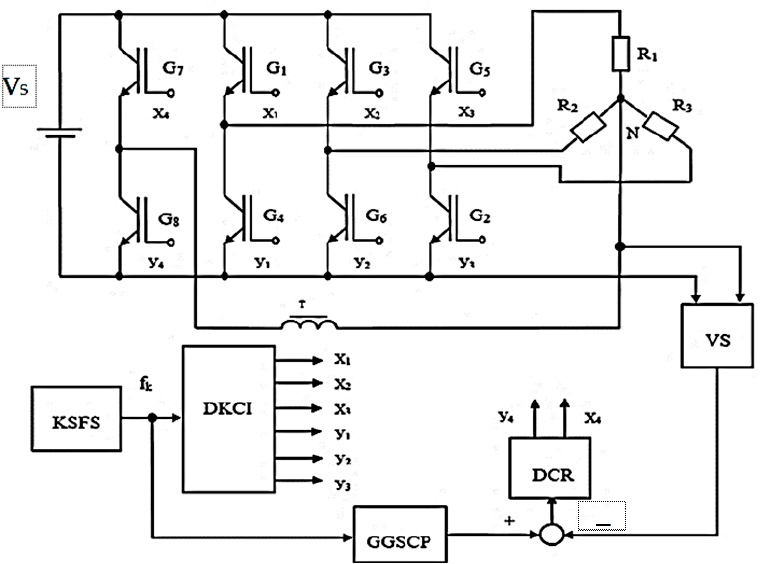
Figure 6. Diagram of the implementation of the symmetry